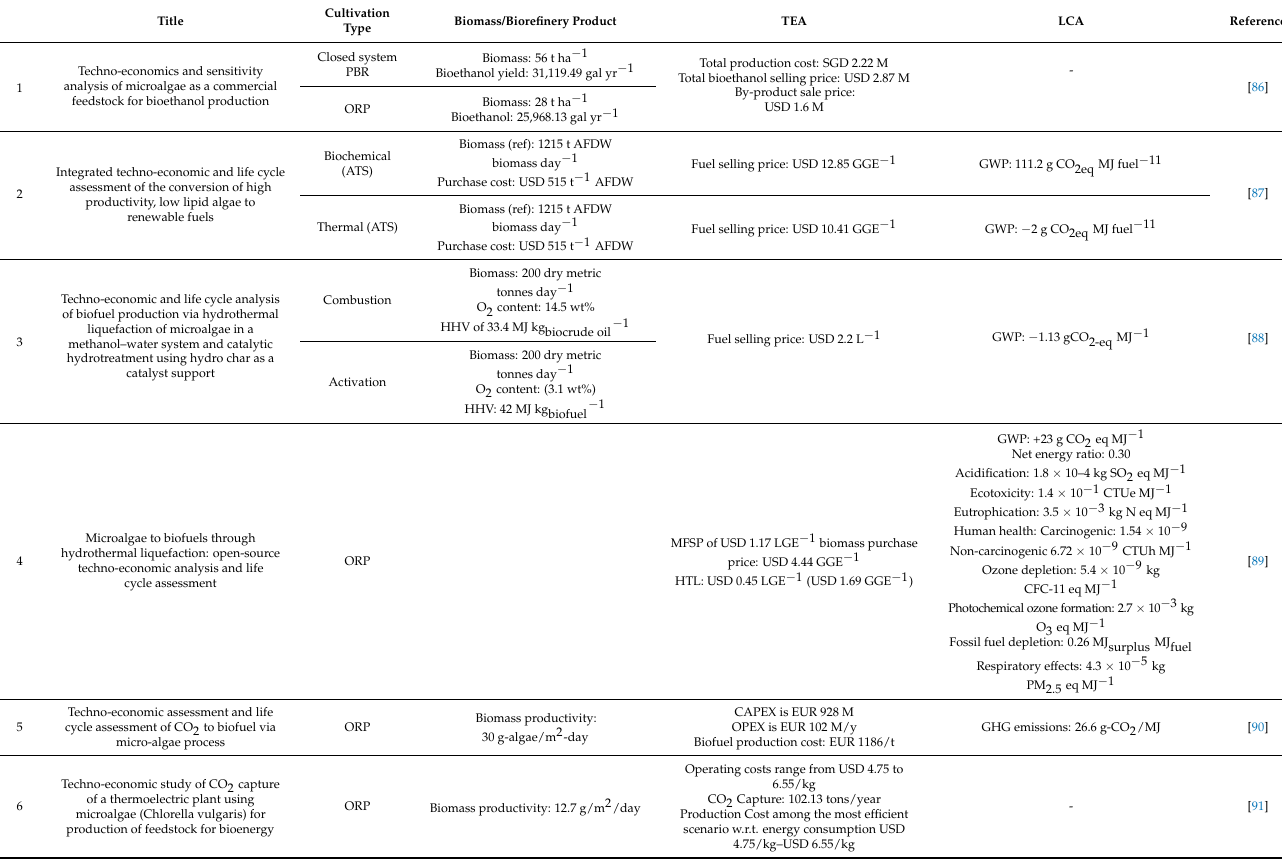
Table 1. Techno-economic analysis and life cycle assessment of some microalgal cultivation processes performed for biorefinery